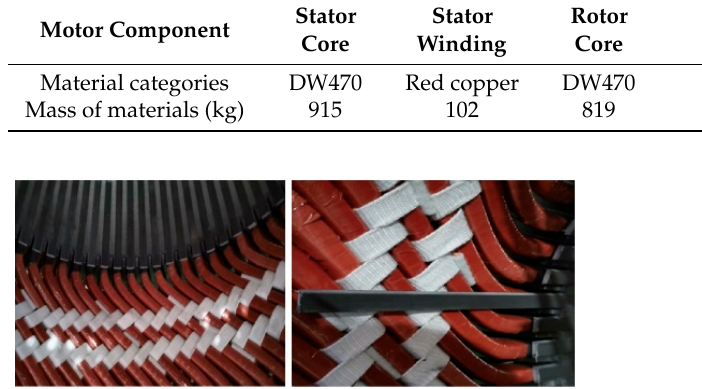
Figure 23. MSW and stator core.